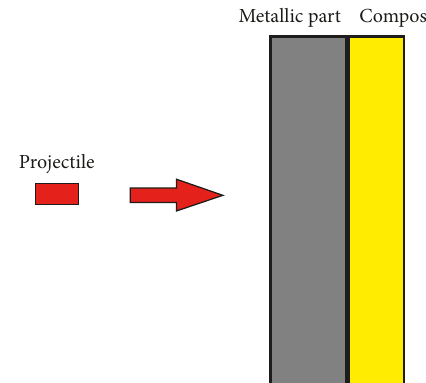
Figure 13: Schematic view of the target made with metallic and composite parts submitted to FSP impact at 630m/s according to STANAG 4569 standard [111].